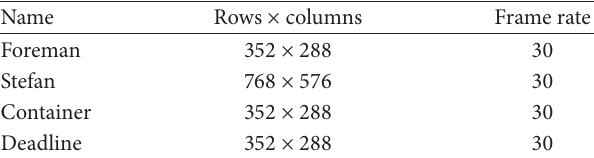
Table 1: Video sequences used for performance evaluation.